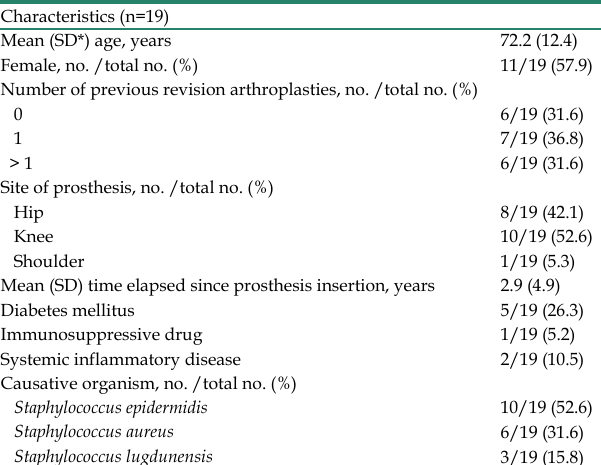
Table 1. Characteristics of the studied population. Characteristics (n=19) Mean (SD*) age,